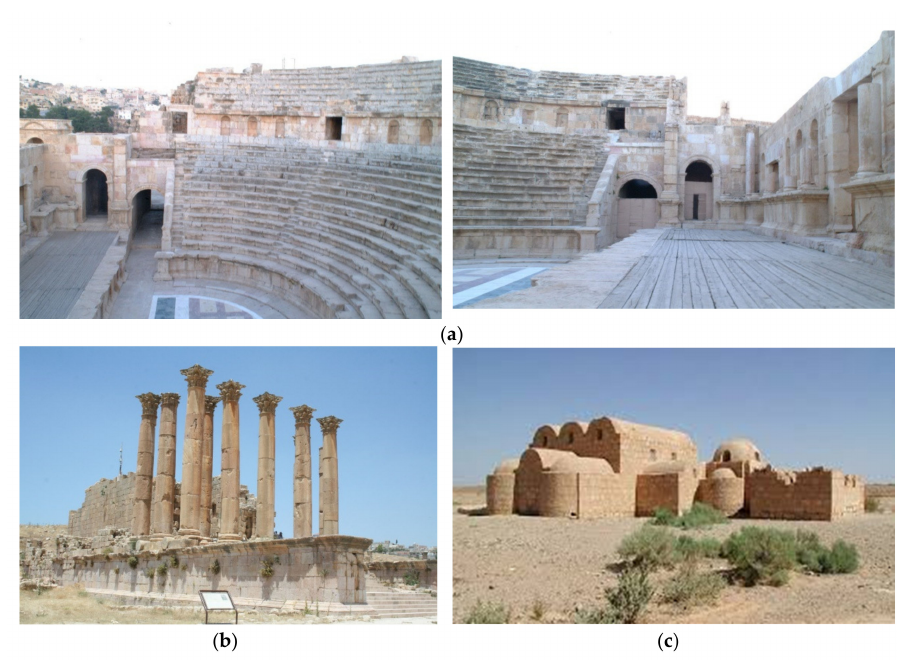
Figure 3. ( a ) The Northern theatre; ( b ) Artemis Temple; ( c ) Qusayr